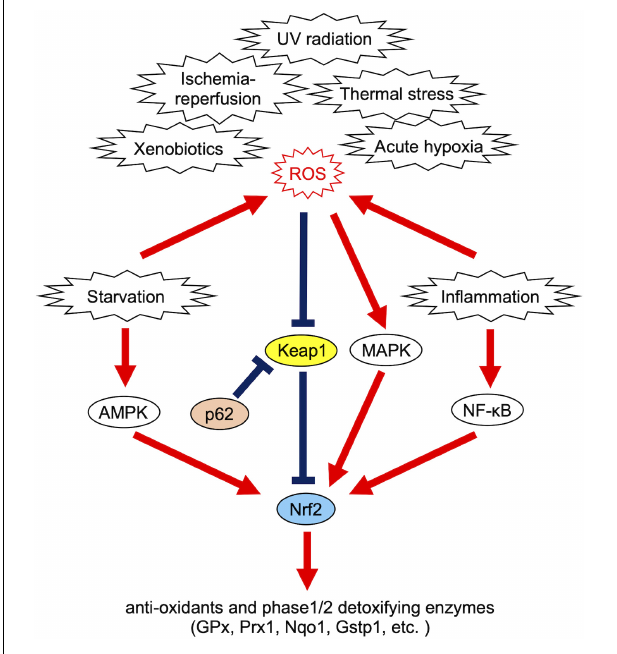
FIGURE 2 | Causes of redox imbalance and Nrf2-associated cellular response